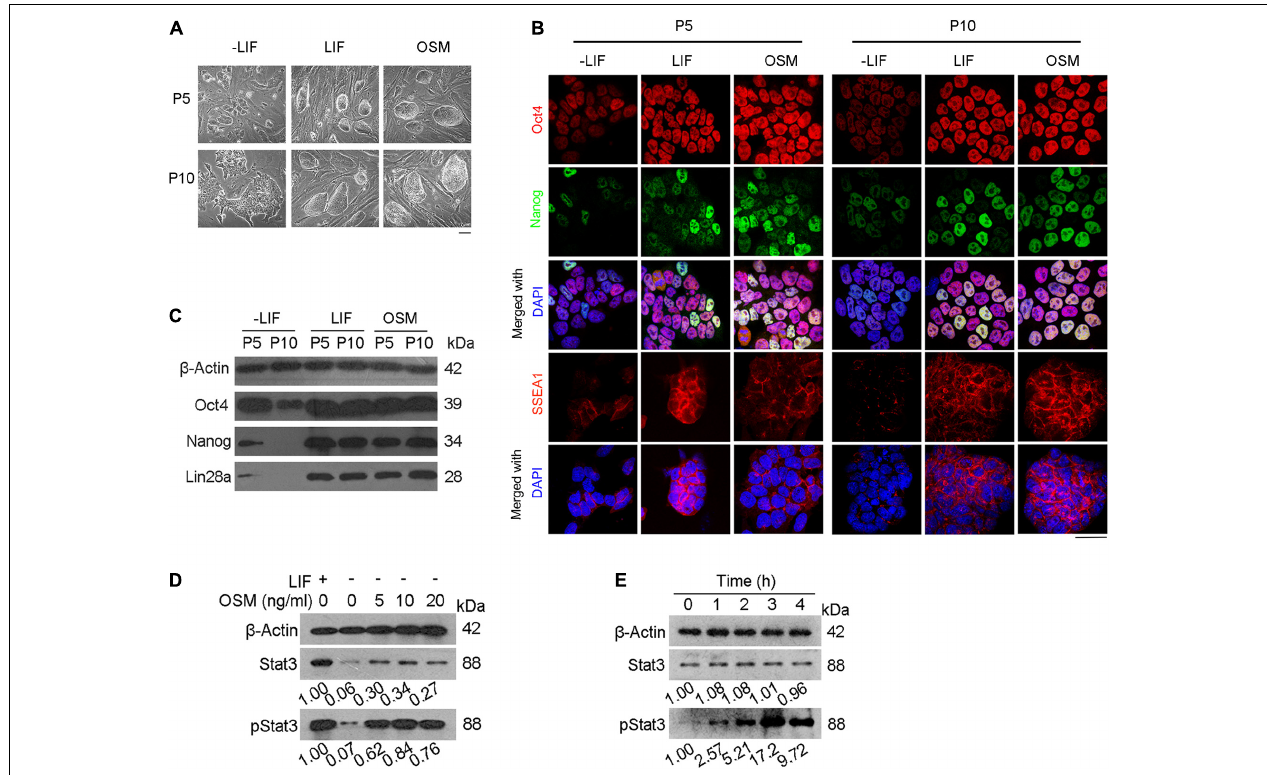
FIGURE 1 | OSM activates Stat3 pathway and sustains expression of pluripotency genes. (A) Morphology of mESCs cultured in ESC basic medium (-LIF), ESC basic medium with LIF (LIF) and ESC basic medium with OSM (OSM). Scale bar, 100 µ m. (B,C) Expression of pluripotency genes cultured in -LIF, LIF and OSM medium at P5 and P10 by immunofluorescence (B) and western blot (C) . Scale bar, 20 µ m. (D) Western blot analysis of Stat3 activated by treatment with different concentrations of OSM for 24 h. (E) Western blot analysis of Stat3 activated by treatment with 10 ng/mL OSM for different lengths of time.